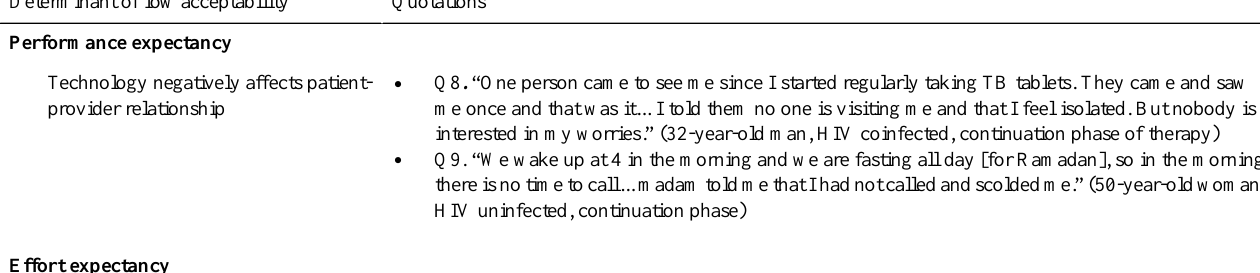
Table 2. Representative quotations on determinants of low patient acceptability and use of